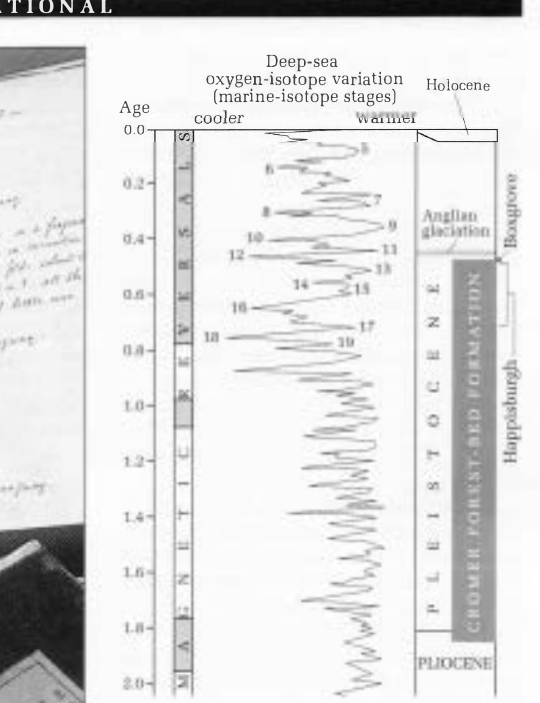
Figure 4 Chronology of the past two mil­ lion years, showing the positions of the Cromer Forest-bed Formation and the Anglian glaciation in relation to those of the pre-Anglian Lower Palaeolithic sites of Happisburgh and Boxgrove, and changes in global climate inferred from variations Figure 2 The bison foot bone from Happisburgh, with A. C. Savin's catalogue of his in oxygen isotopes in the shells of marine collection of vertebrate fossils from the Forest-bed. micro-organisms (foraminifera) preserved in deep-sea sediments. The deep-sea oxygen-isotope stages are numbered glacial sediments there is a deep sequence mammalian specimens from sequentially back in time from the present of mainly estuarine and marine deposits Happisburgh loose on the interglacial period(= Marine Isotope Stage (resting on chalk bedrock), which he cor­ beach) were studied by Adrian Lister of the 1). Changes in Earth's magnetic field (mag­ related with the early part of the Forest-bed netic reversals) provide a means of corre­ c. 1.8-1.6 million years ago (Fig. 4). lating the marine oxygen-isotope curve with terrestrial deposits; grey areas in the column indicate normal polarity (when the Earth's magnetic polarity was